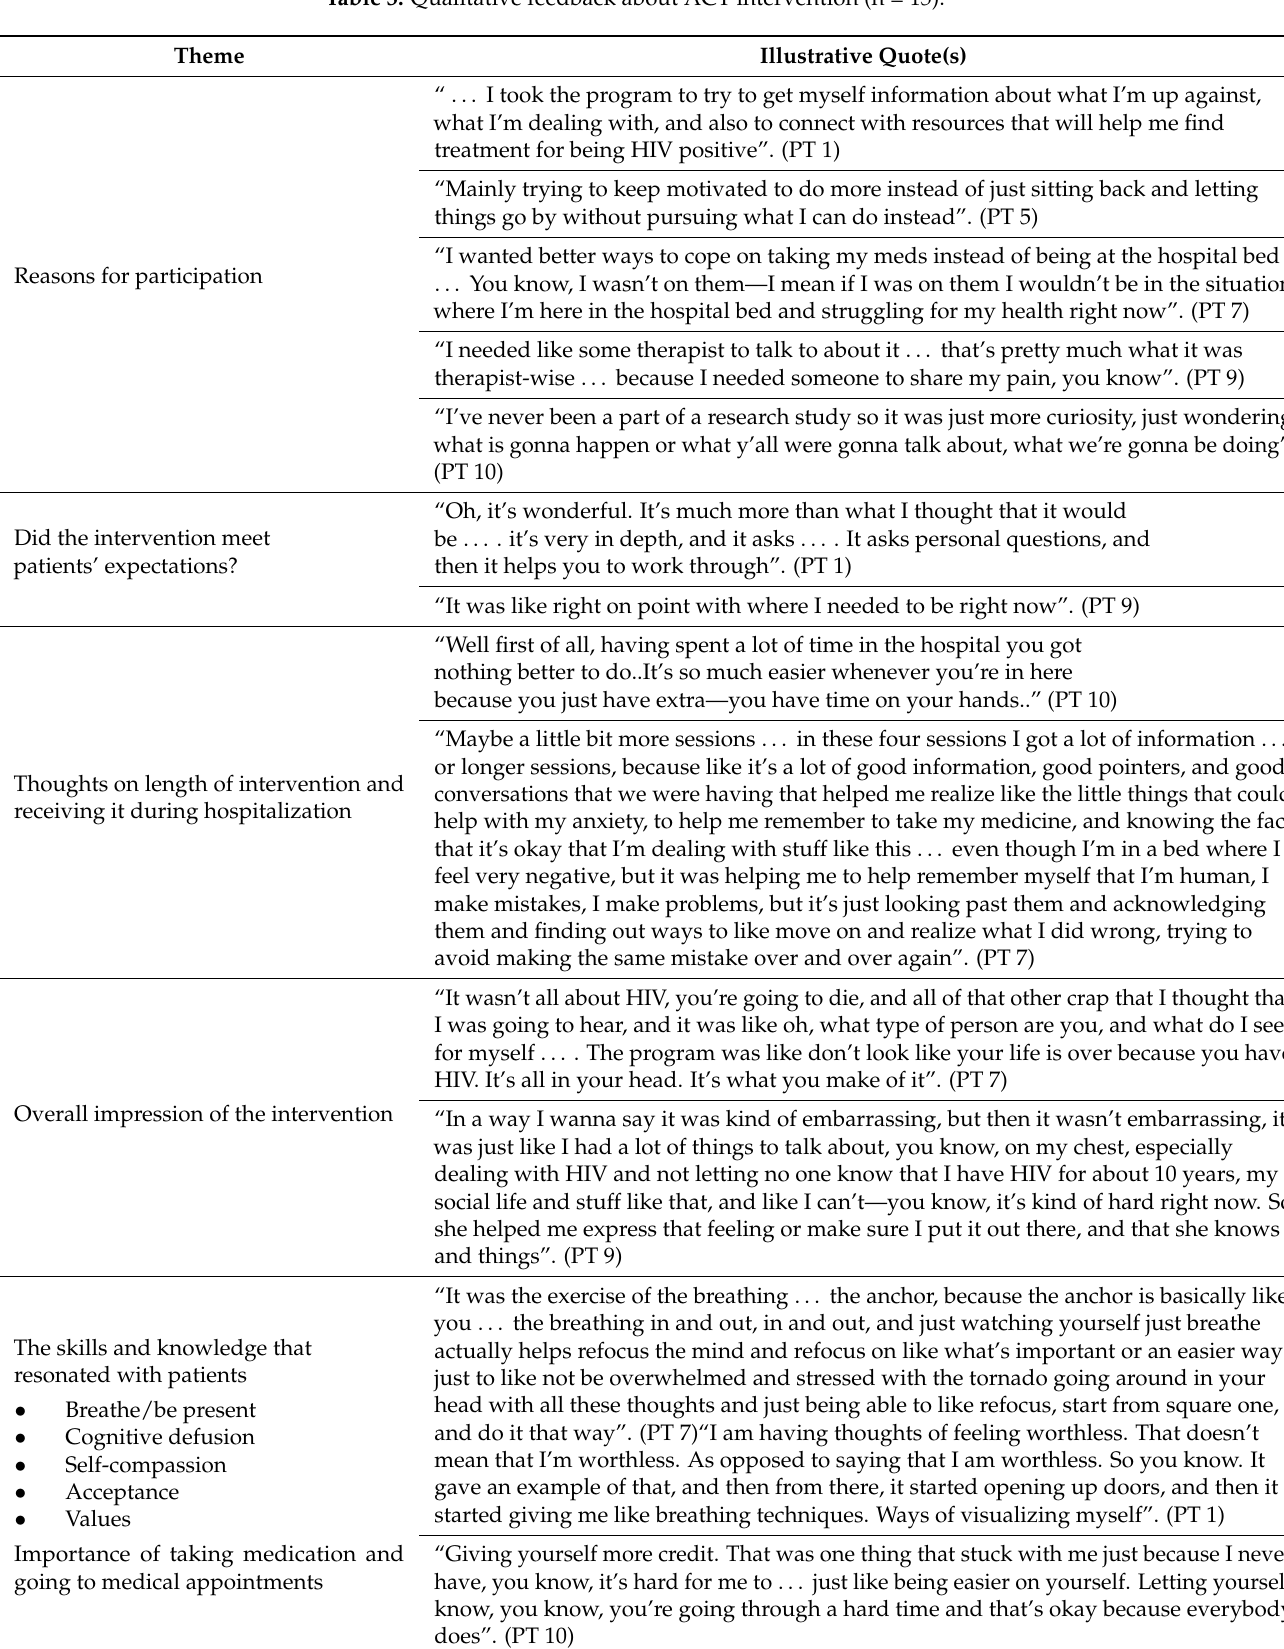
Table 3. Qualitative feedback about ACT intervention (n =